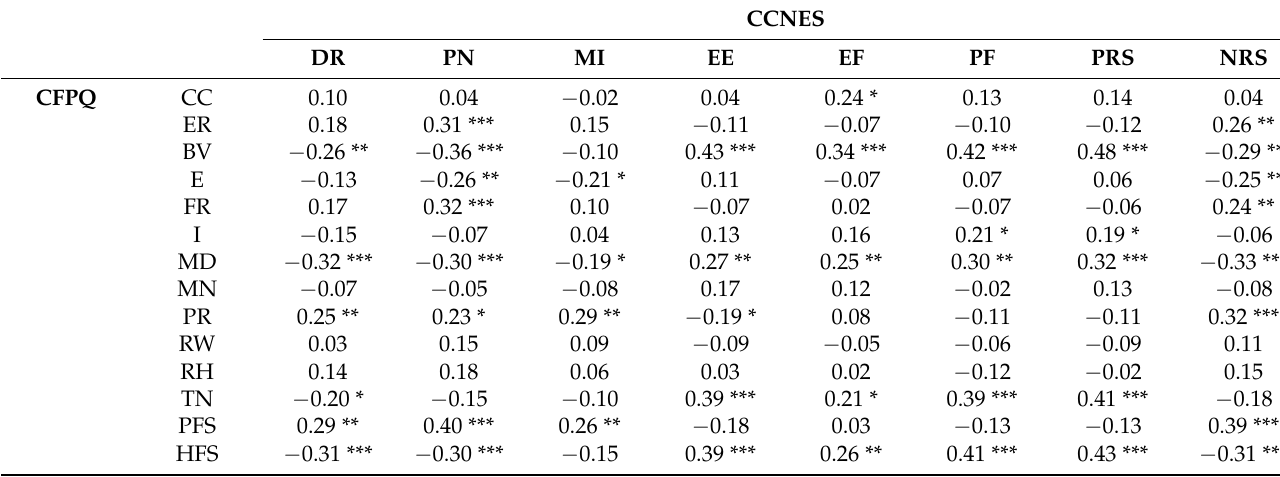
Table 2. Correlation between Coping with Children’s Negative Emotions Scale and Comprehensive Feeding Practices Questionnaire dimensions and composites, controlling for child sex and age and parents’ education